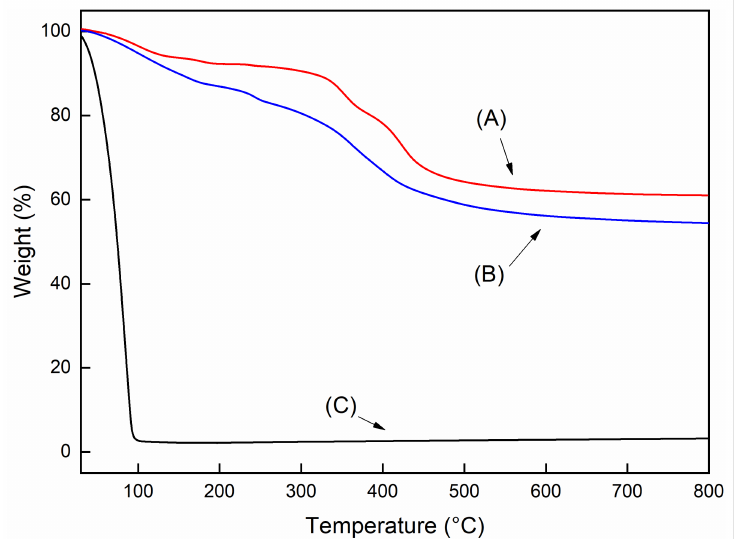
Figure 2. TGA of the pristine LDH with chloride anion (A), LDH modified with MA (B) and MA